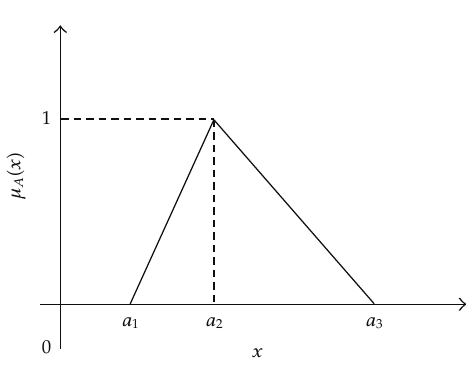
Figure 1: A triangular fuzzy number A